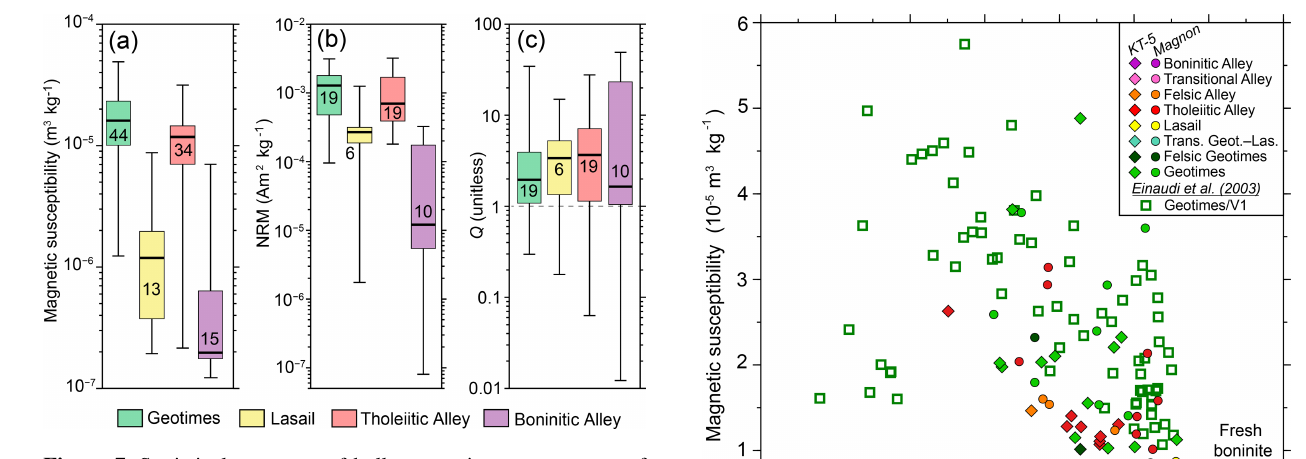
Figure 7. Statistical summary of bulk magnetic measurements of hand specimens of the Semail volcanic units carried out for this study. Bold lines: medians. Coloured boxes: interquartile ranges. Whiskers: minimum–maximum. Felsic subunits are grouped with parent units. Numbers in coloured boxes show number of sam- ples analysed. (a) Magnetic susceptibility (both Magnon and KT-5 measurements grouped). (b) Natural remanent magnetism (NRM), un-oriented samples. (c) Königsberger ratios ( Q ) of remanent-to- induced magnetisation calculated for each sample with un-oriented NRM, a density of 2.67gcm − 3 (mean for Geotimes spilites; Einaudi et al., 2003) and the local geomagnetic field for 1992 (42900nT; Thébault et al., 2015).